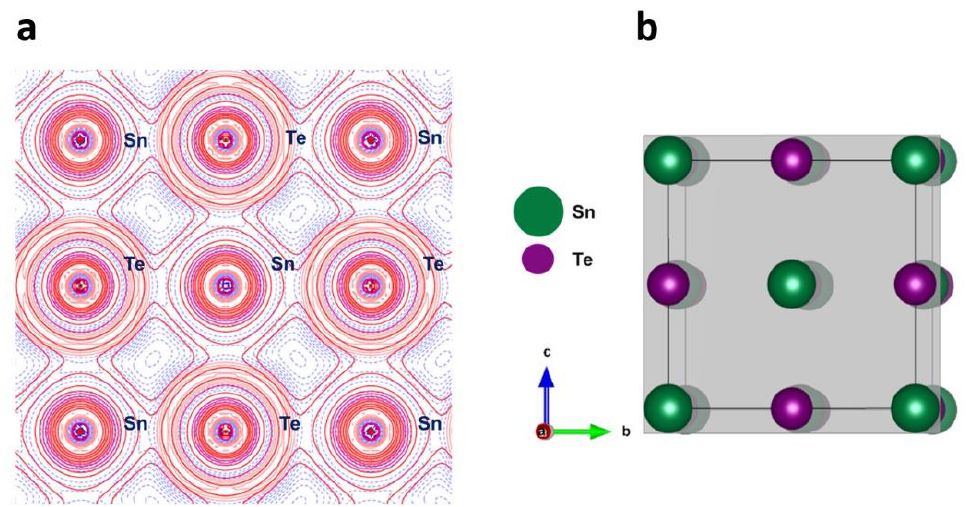
Figure 5. ( a ) Laplacian of the electronic density map of ( b ) the <100> planes of the SnTe structural model.